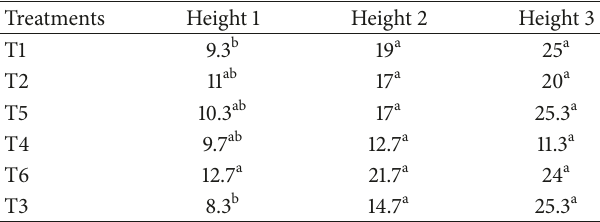
Table 5: Means of chilli heights.